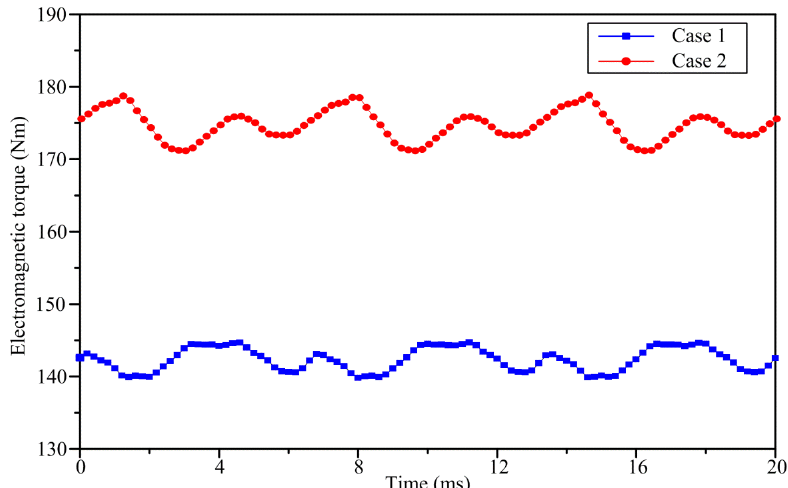
Figure 7. Comparison of pull-out